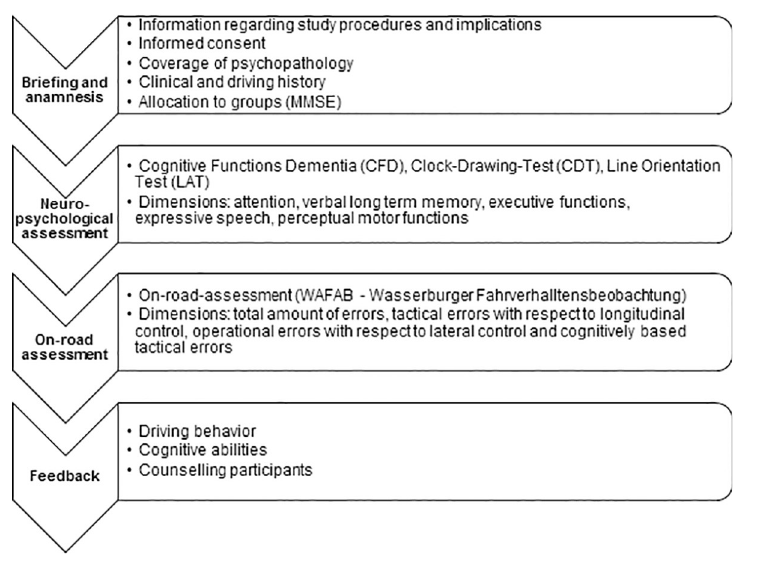
Fig 1. Flowchart of the study